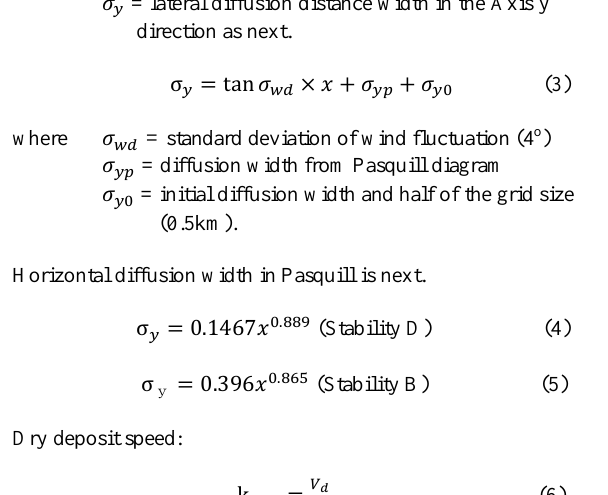
Figure 2. Wind directions each height were quite